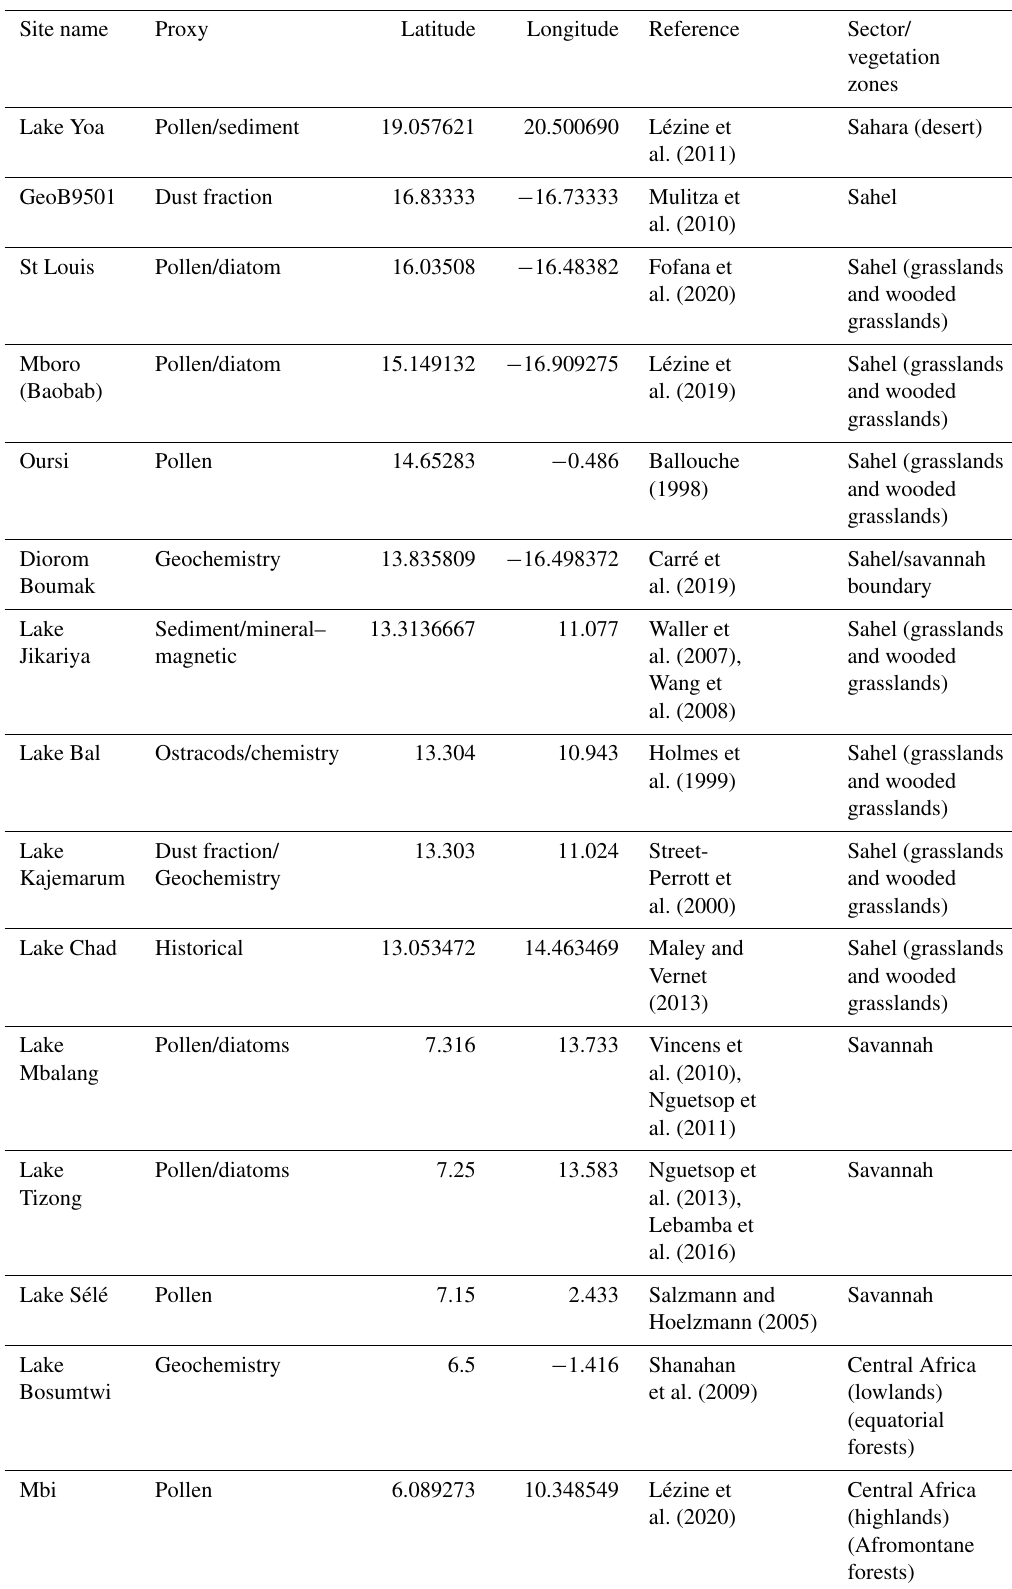
Table 1. Geographical positions, type and references of paleo-records used in this study (see Fig.